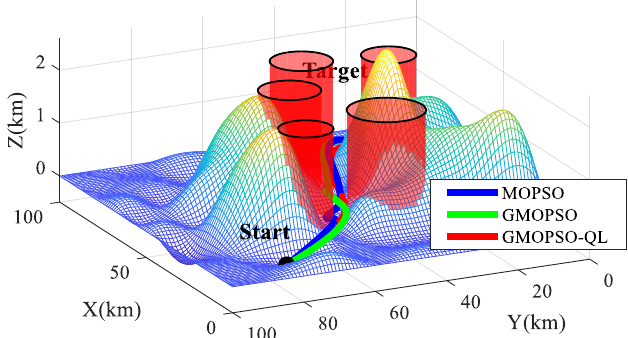
Figure 4. 3D view of the best flight paths in Case 1.